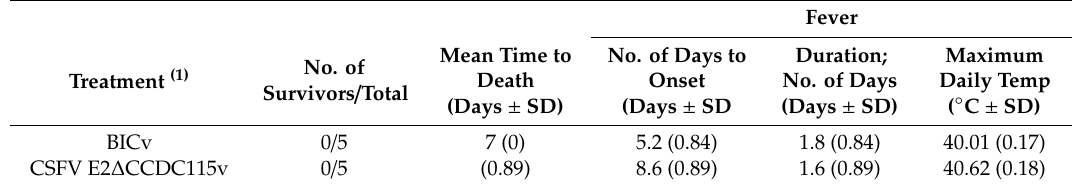
Table 1. Swine survival and fever response in animals infected with mutant E2 ∆ CCDC115v compared with those infected with parental BICv.